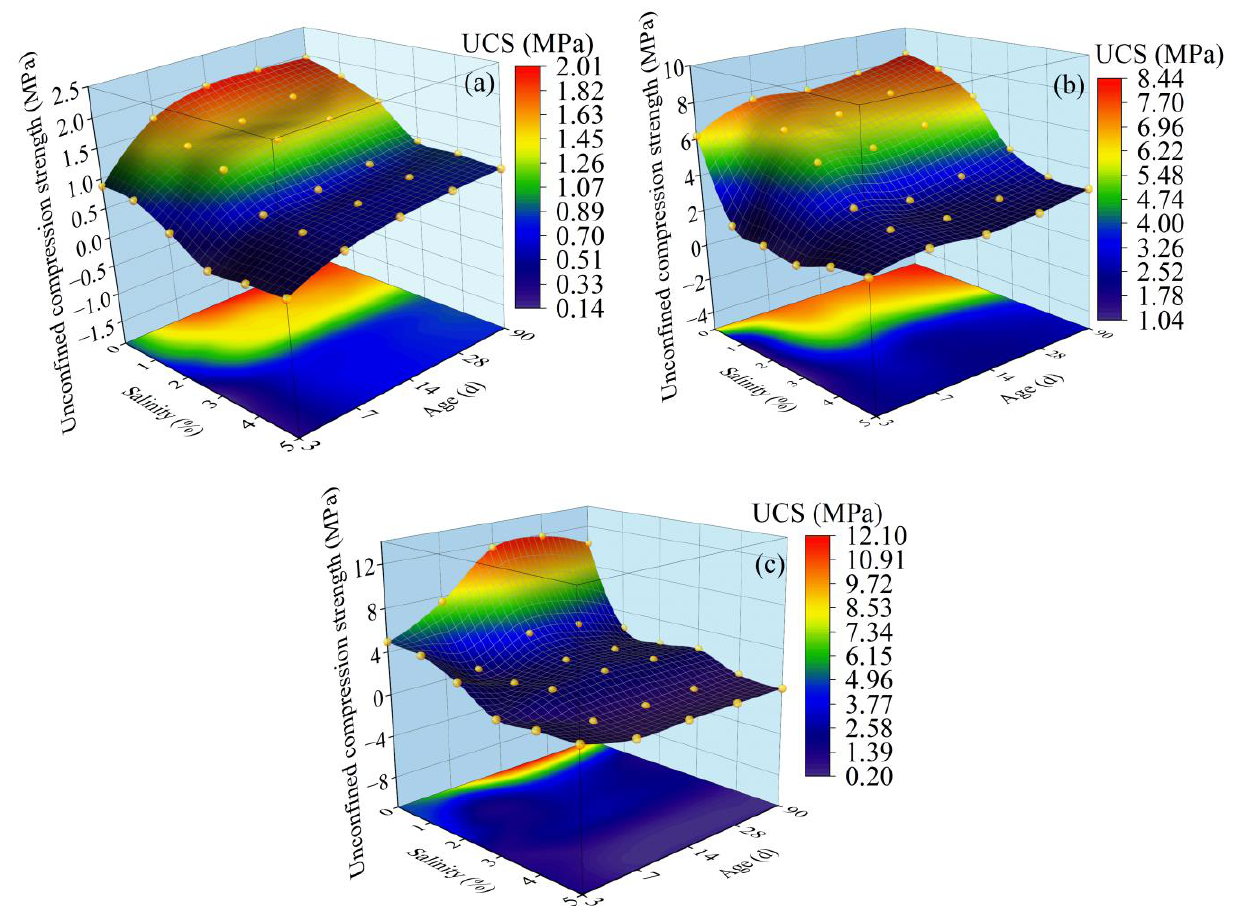
Figure 2. Effect of salt content and age on compressive strength of improved soils. Notes: ( a ) Ambient temperature of unconfined compression test (UCST) at 20 °C; ( b ) ambient temperature of UCST at − 10 °C; ( c ) ambient temperature of UCST at − 20 °C.